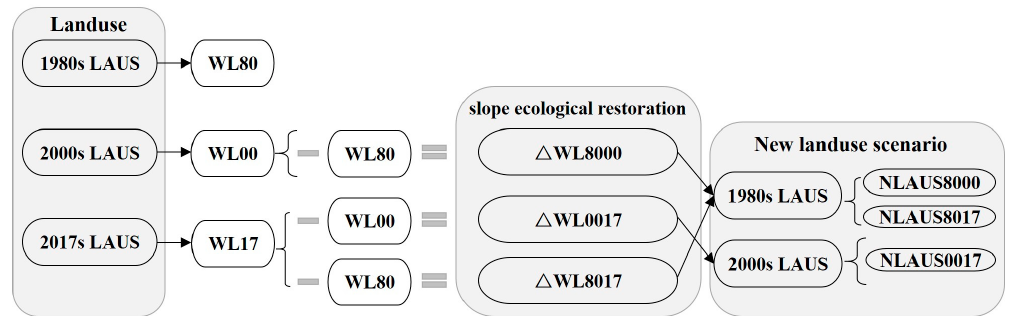
Figure 8. Flow chart of the slope ecological restoration scenarios constructed in different periods (1980s LAUS, 2000s LAUS and 2017s LAUS refer to landuse in 1980, 2000, and 2017, respectively; WL80, WL00 and WL17 refer to forest land in 1980, 2000, and 2017, respectively; △ WL8000, △ WL0017 and △ WL8017 refer to slope ecological restoration in the periods of 1980–2000, 2000–17 and 1980– 2017, respectively; NLAUS8000, NLAUS0017, and NLAUS8017 refer to the underlying surface scenarios considering slope ecological restoration in the periods of 1980–2000, 2000–17 and 1980–2017, respectively).